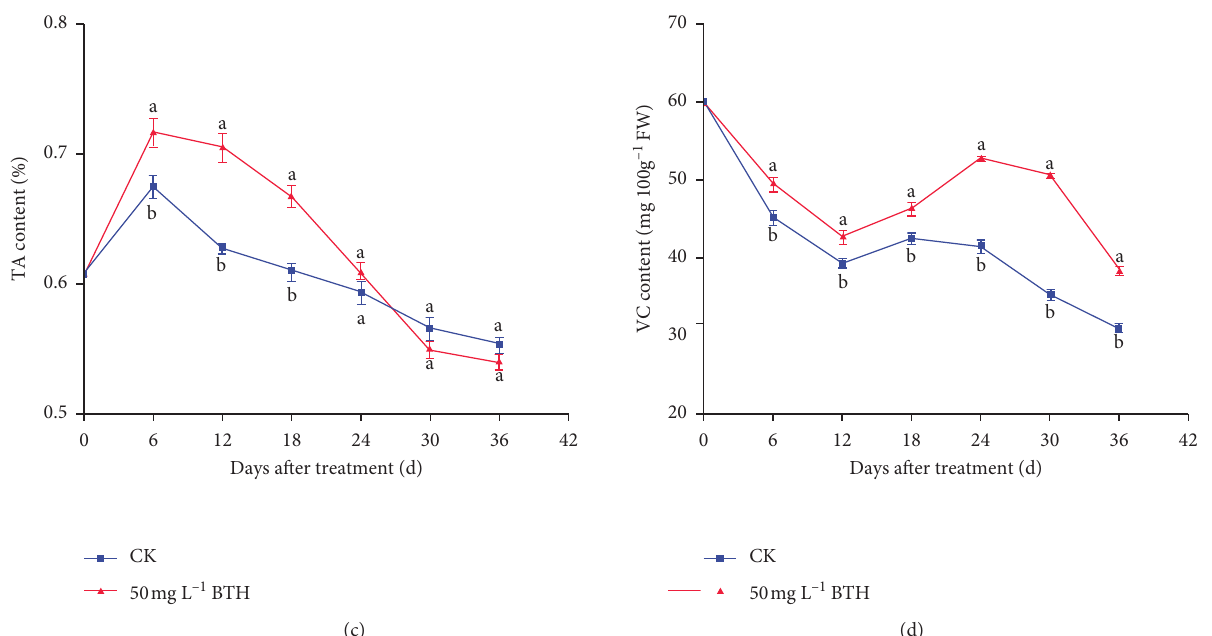
Figure 2: Effects of BTH on weight loss, SSC, VC, and TA contents of navel orange fruits under storage at 20 ° C.